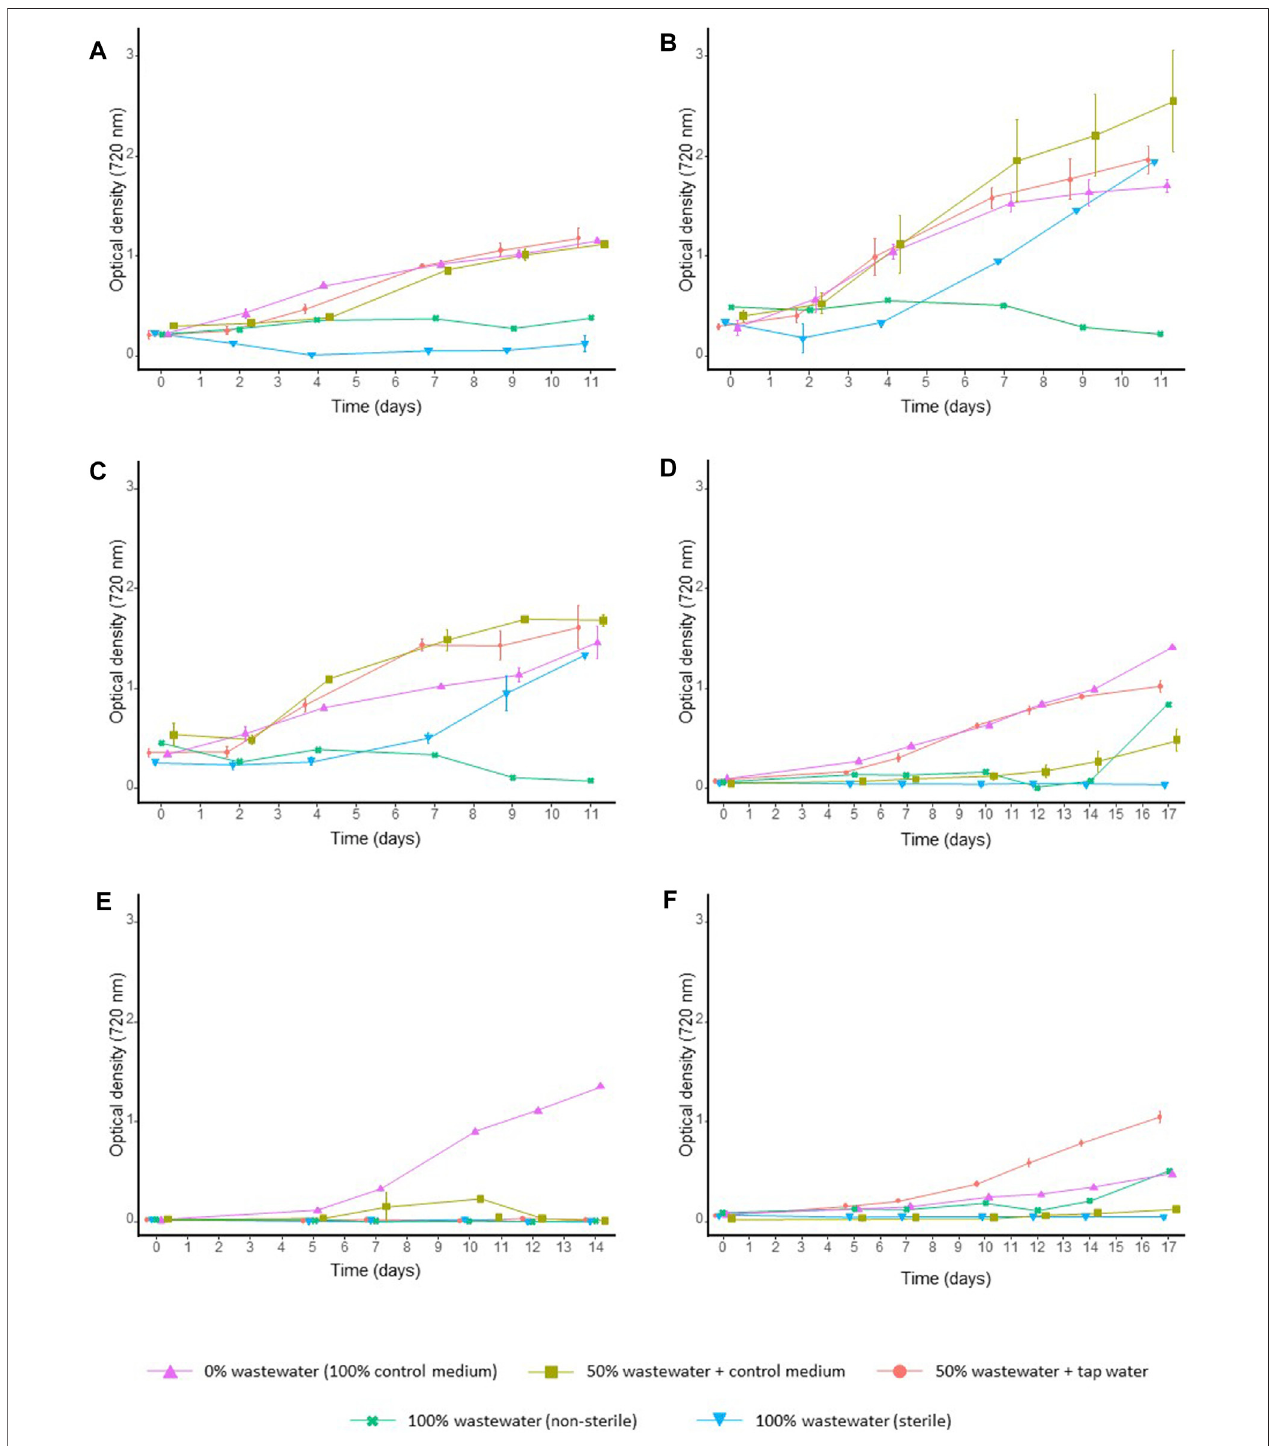
FIGURE 3 | Growth curves (based on optical density) of microalgal strains on poultry wastewater dilutions. Culture growth was monitored for 12 – 18 days through opticaldensity(720 nm)measurementsfor (A) A.obliquus , (B) C.sorokiniana , (C) C.vulgaris , (D) D.armatus , (E) M.gaditana and (F) P.kessleri .Theresultsaregivenas the average of two values, and whiskers delineate the standard deviation.